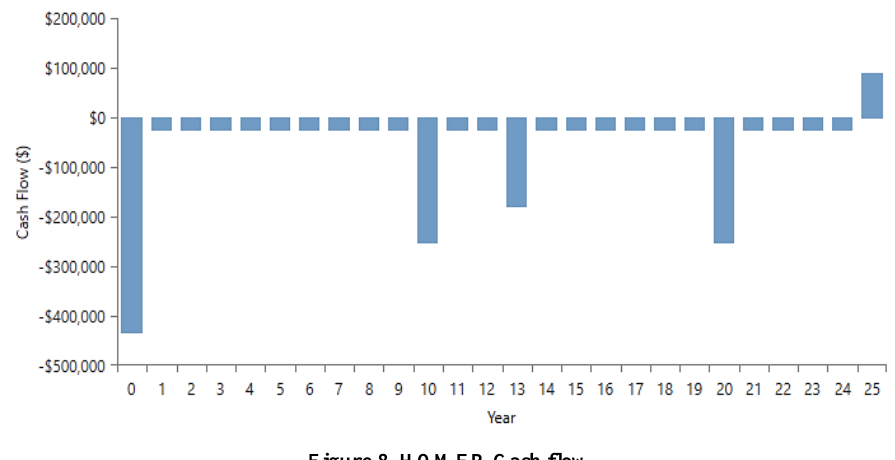
Figure 8. HOMER Cash